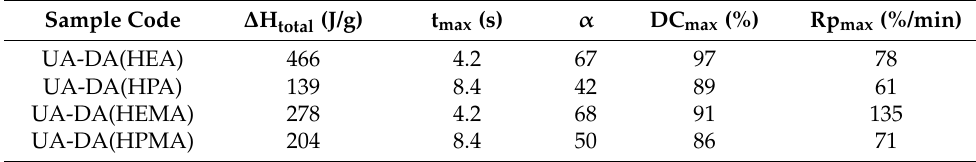
Table 2. Characteristics of the photocuring process of UA-DA resins.